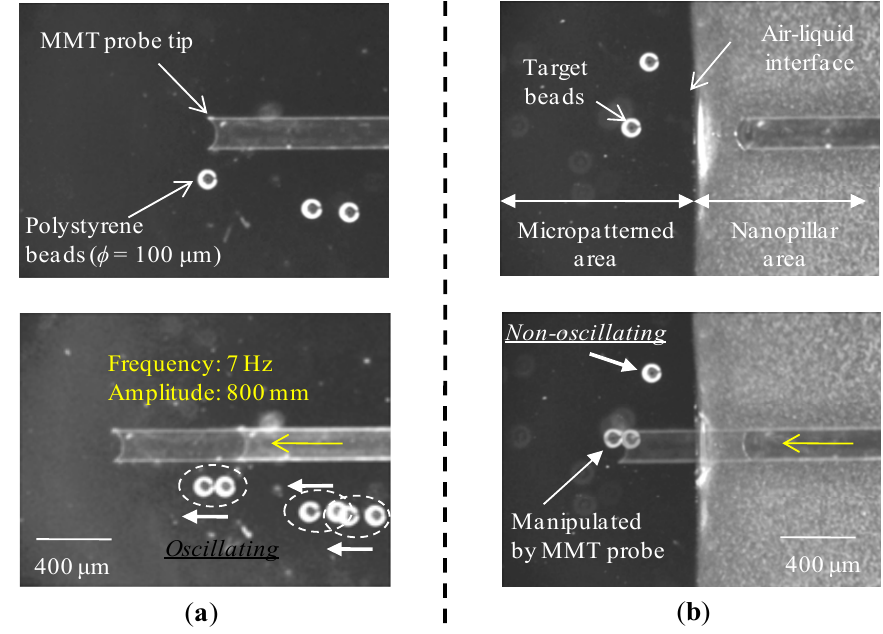
Figure 8. Photographs of insertion of a probe tip of magnetically driven micro-tools (MMTs) into ( a ) the previous microchannel and ( b ) surface-directed liquid flow.